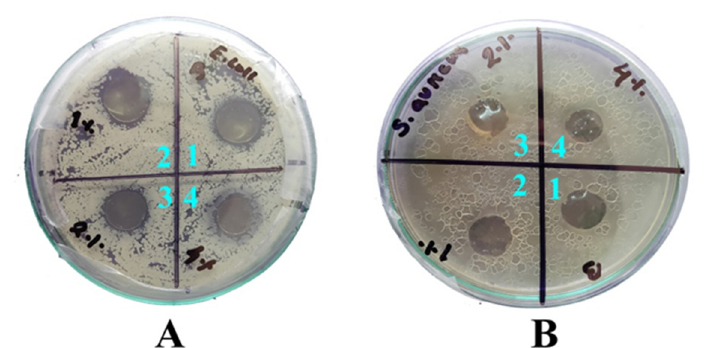
Figure 6. Antimicrobial activity of the films (1) CH / GL only, (2) CH / GL / ZnO (1%), (3) CH / GL / ZnO (2%), and (4) CH / GL / ZnO (4%) against ( A ) Escherichia coli , and ( B ) Staphylococcus aureus , after 24 h